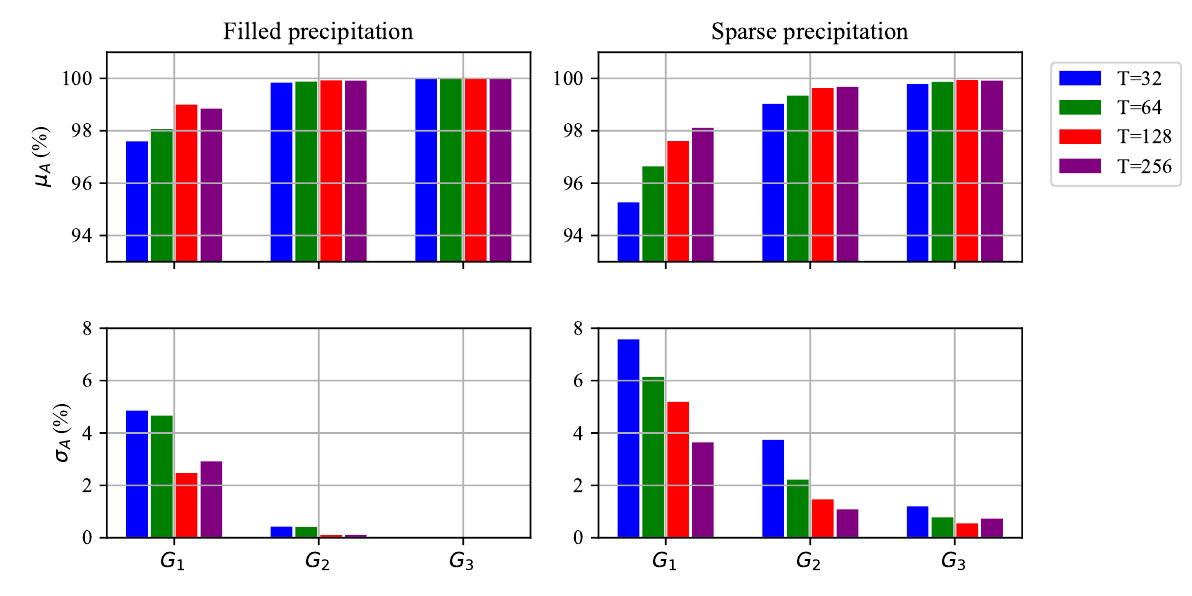
Figure 9. Comparisons of the performance of the trained CNN with different template sizes ( T ), i.e., 32 (blue), 64 (green), 128 (red), and 256 (purple) range gates on mostly filled precipitation (left), and sparsely filled precipitation (right). It is tested with three different v a group, i.e., G 1 , G 2 , and G 3